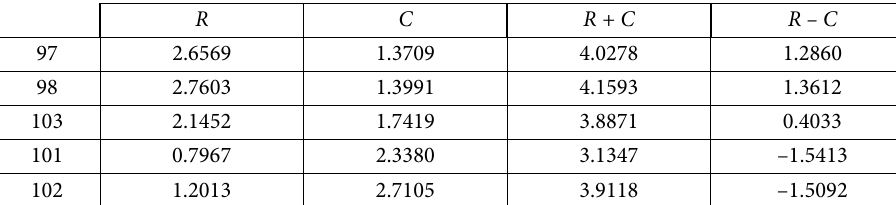
Figure 6. DEMATEL relationships diagram for C4 Table 22. Auxiliary calculations for C4 Culture